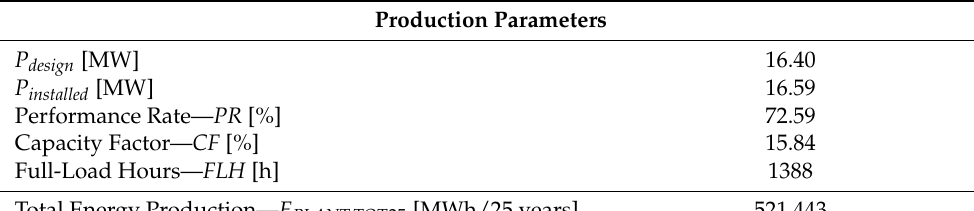
Table 2. Photovoltaic solar generation system production parameters.